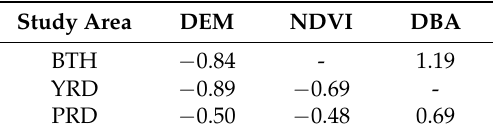
Figure 5. Spatial distribution of coefficients and local R 2 of DEM ( a , b ), NDVI ( c , d ), and DBA ( e , f ) by GWR in the PRD. Table 5. The coefficients of the independent variables by OLS.